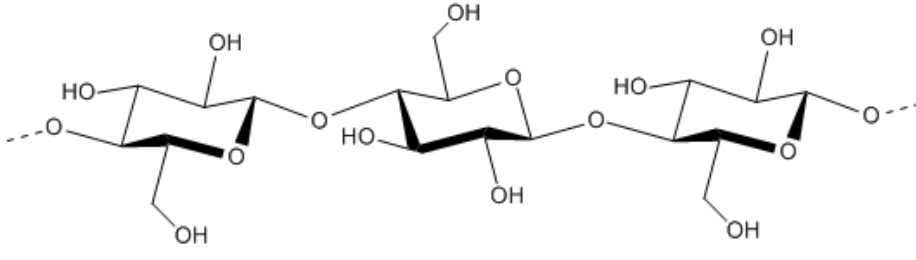
Figure 3. The structure of bacterial cellulose [80].